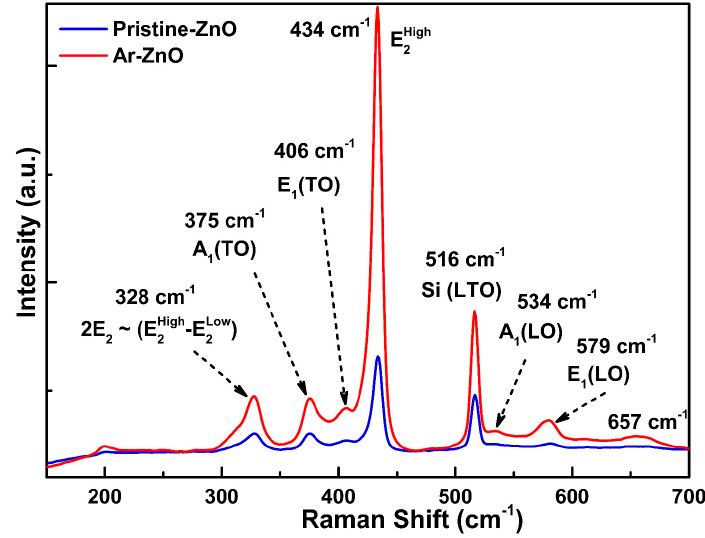
Figure 6. Raman spectra of pristine ZnO and Ar-ZnO nanowires.